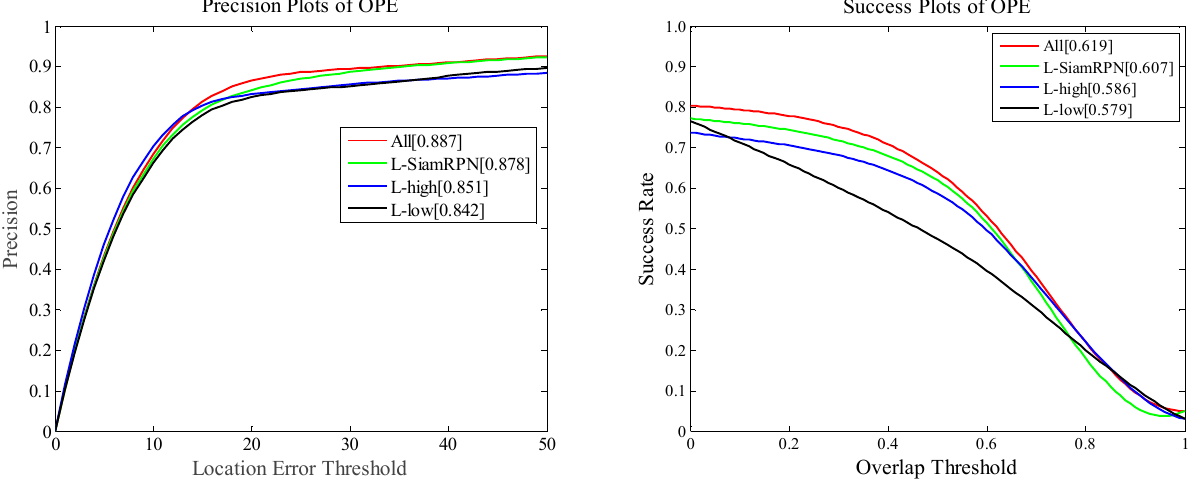
Figure 8. The impact of different losses on five benchmarks.